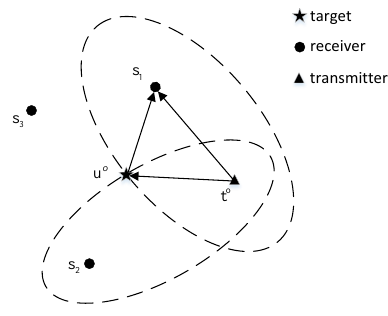
Figure 1. Illustration of elliptic